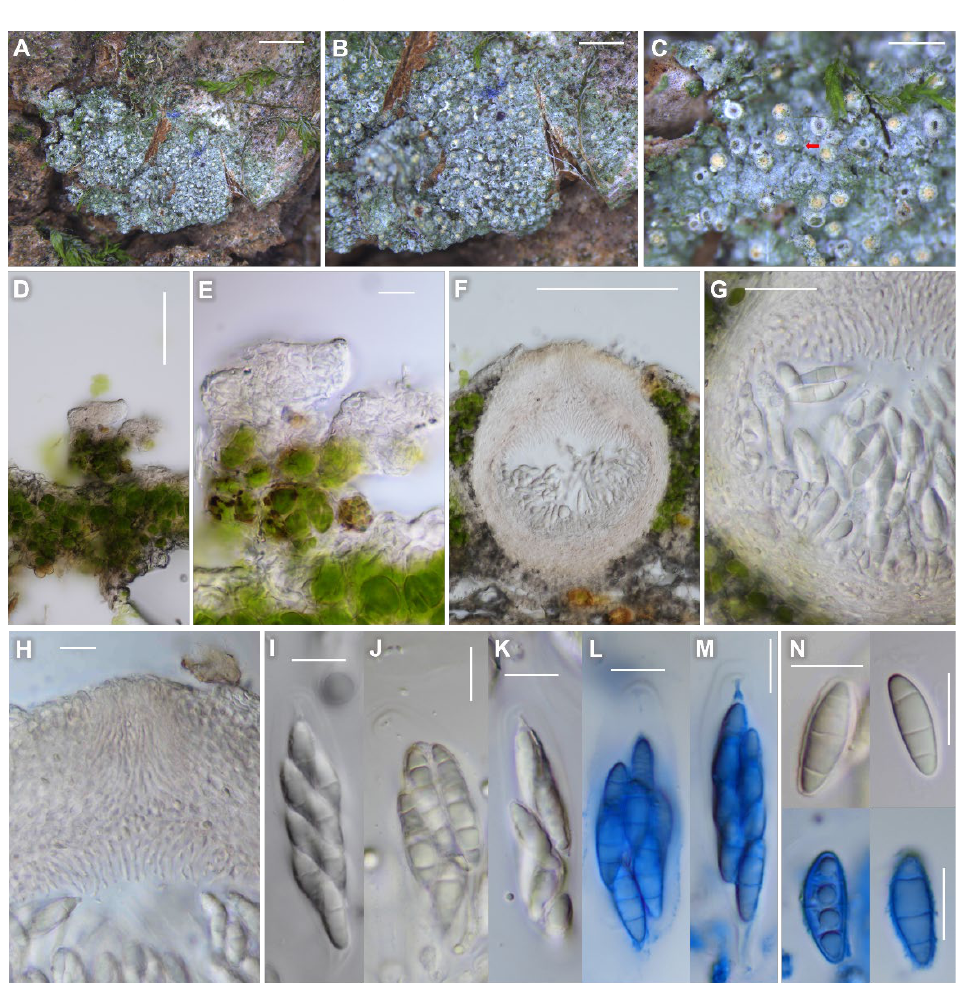
Figure 5. Psoroglaena humidosilvae (KBA-L-0002007, holotype for ( A – C ), ( F – N ); KBA-L-0002005, paratype for ( D – E ) in morphology. ( A – C ) Habitus and apothecia on bark of Salix koreensis . A minute filament (red arrow) shown in ( C ). ( D – E ) Appressed filaments (papillae) as minute projections on thallus. ( F ) Globose perithecia without involucrellum. ( G ) The 5- to 6-layered excipulum. ( H ) Ostiolar region with periphyses. ( I – M ) Asci clavate to cylindrical. ( N ) Ascospores generally 3-septate. Blue colors stained in Lactophenol cotton blue in ( L – N ). Scale bars: ( A ) = 2 mm, ( B ) = 1 mm, ( C ) = 500 μm, ( D ) = 50 μm, ( E , H – N ) = 10 μm, ( F ) = 100 μm, ( G ) = 20 μm.